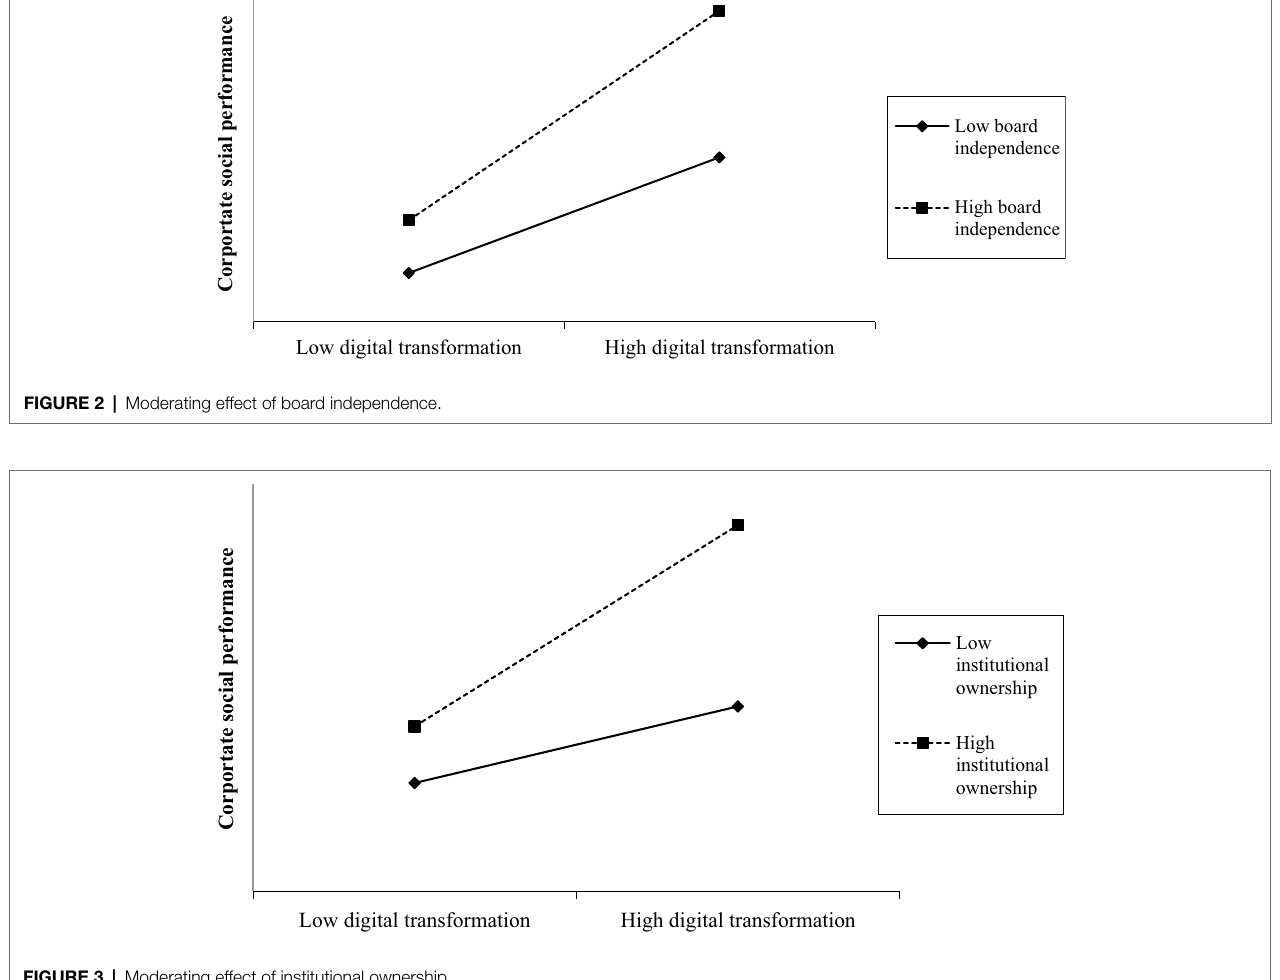
FIGURE 3 | Moderating effect of institutional ownership.